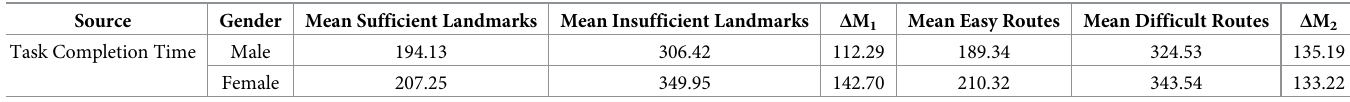
Table 4. Task completion mean.